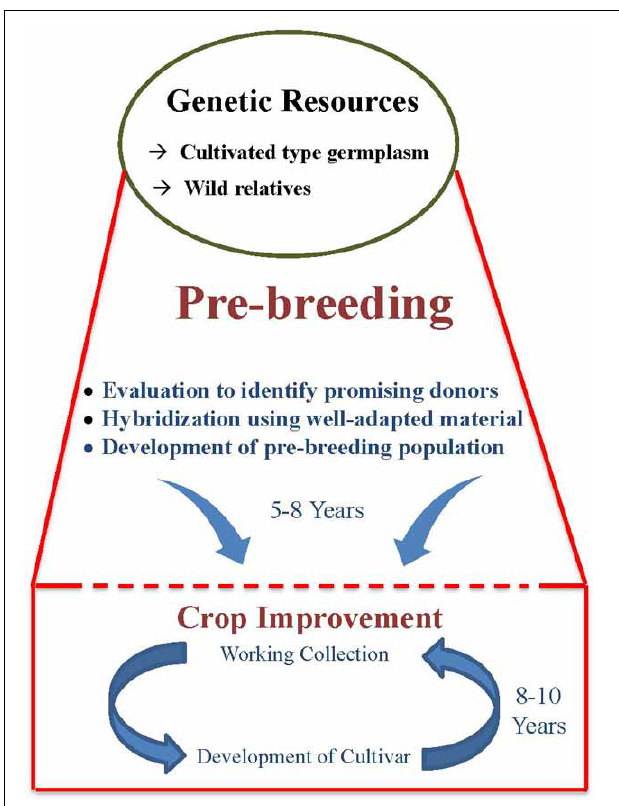
FIGURE 1 | Pre-breeding as a bridge between genetic resources and crop